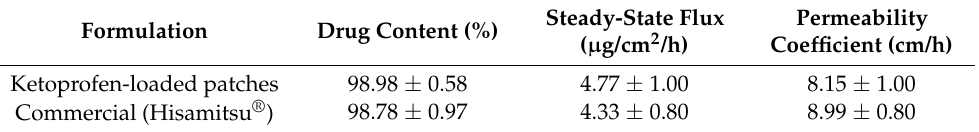
Table 3. Skin permeation parameters and drug content of the drug-loaded patches and the commer- cial